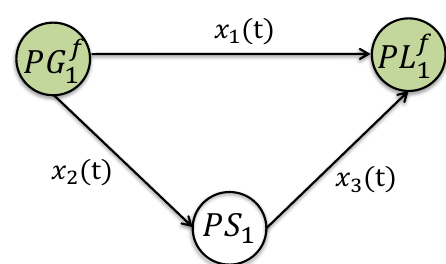
Figure 2. An overview of a simple power flow